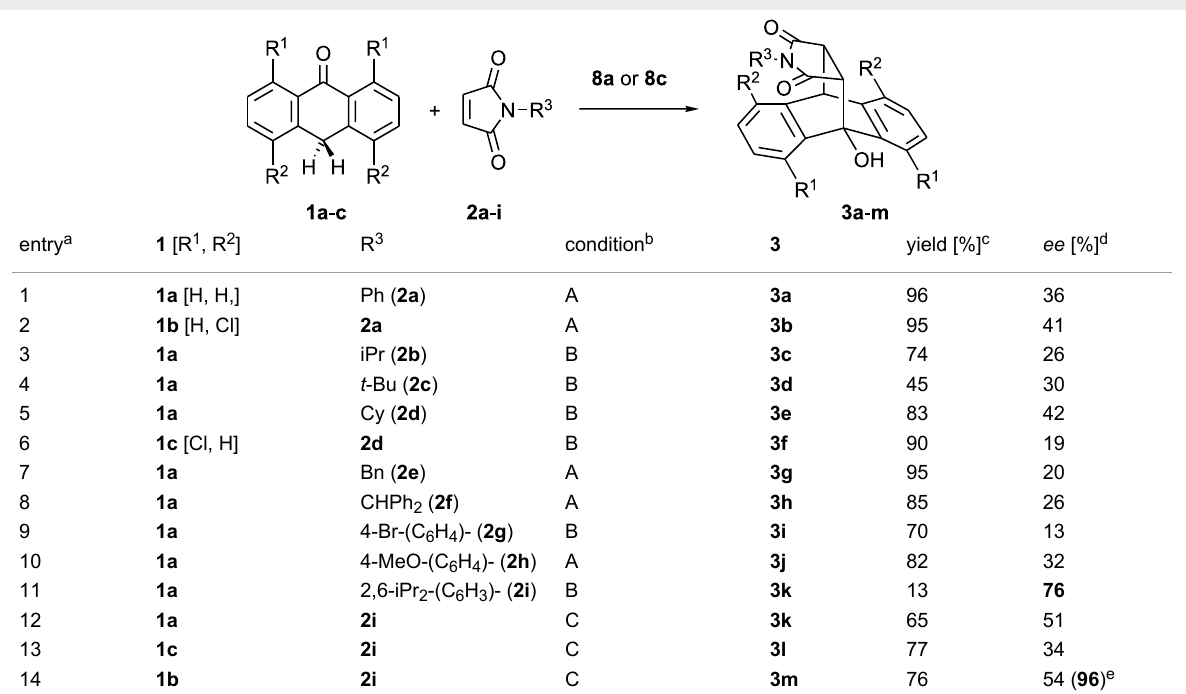
Table 4: Scope of the Diels-Alder-reaction.